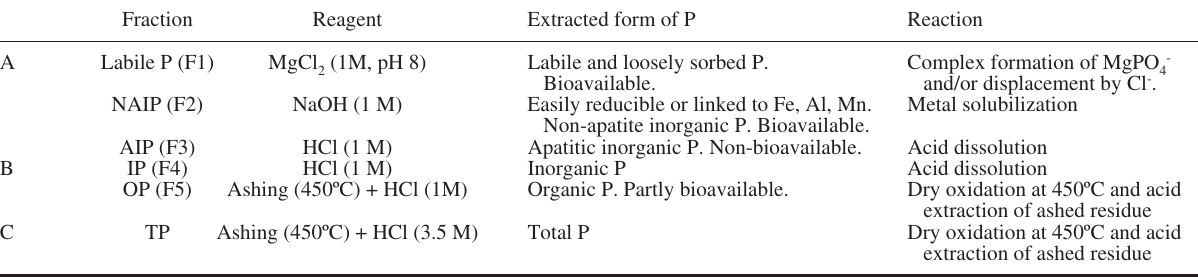
Table 3. – Reagent characteristics and corresponding P fractions in the sequential extraction method applied to three splits of sediment (A, B, C).